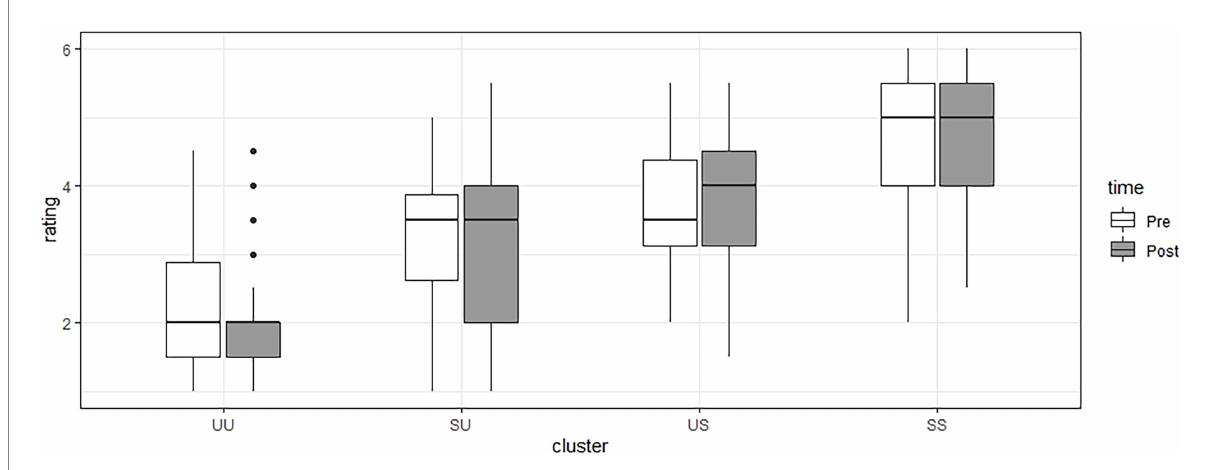
FIGURE 1 Comparisons of mean absolute ratings and mean difference in ratings for each condition between pre- and post-test.